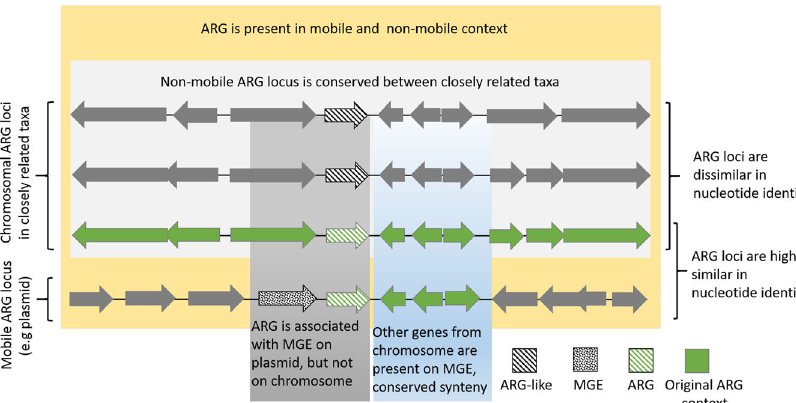
Fig. 3 Assigning the recent origin of an ARG. Graphical representation of strong evidence for assigning the recent origin of an ARG using the evaluation criteria described